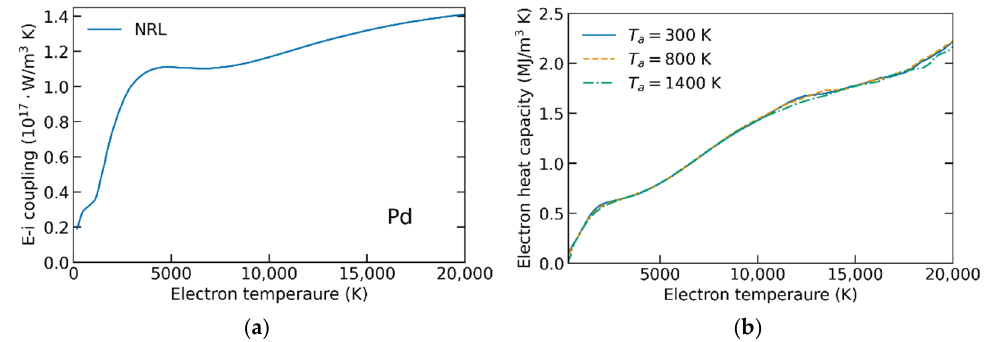
Figure 2. ( a ) Electron–ion couplings G(T e ) in palladium calculated using NRL parametrization. ( b ) Electron heat capacity in palladium calculated for different atomic temperatures.